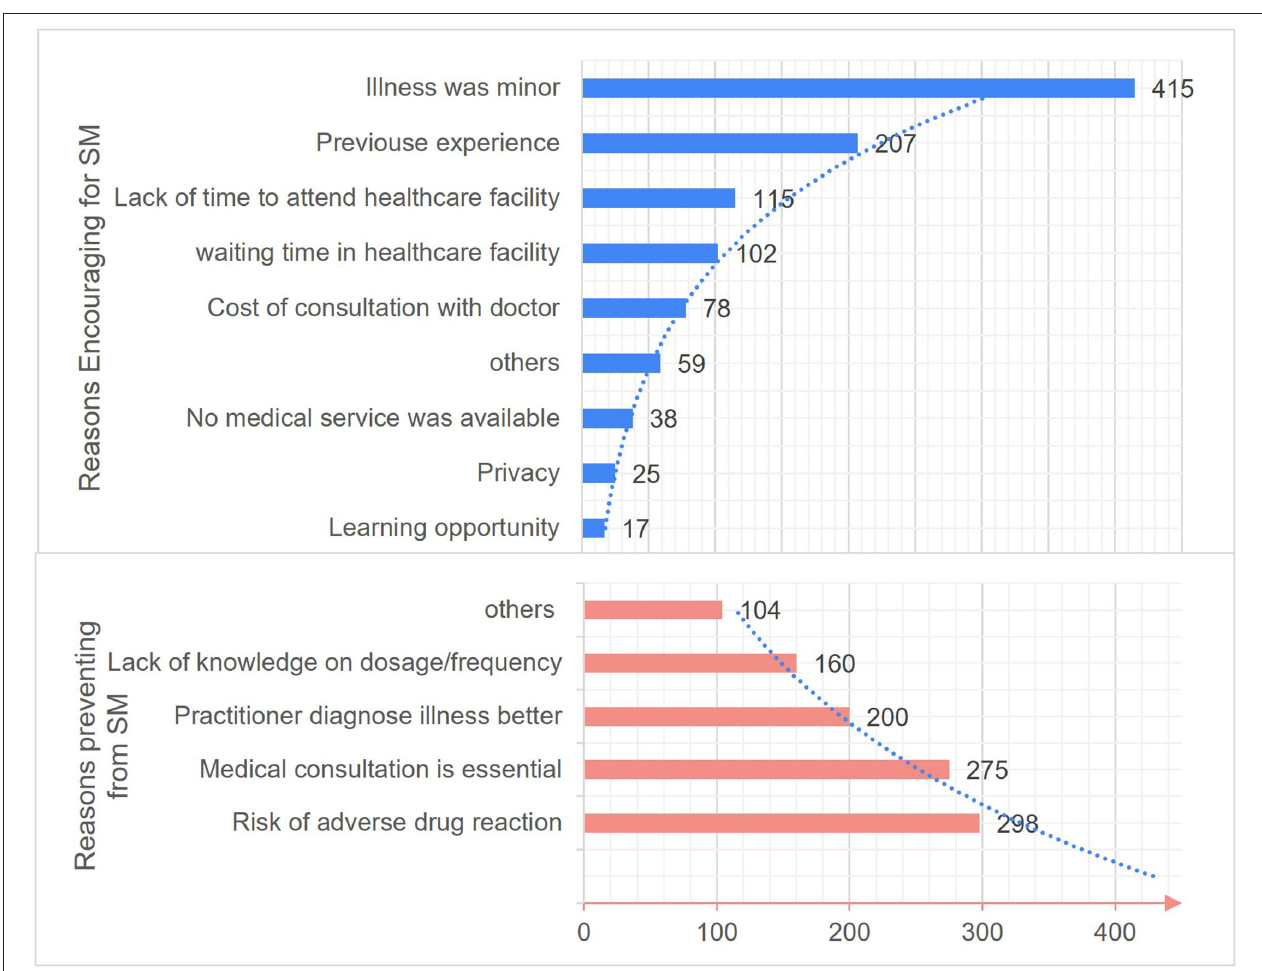
FIGURE 2 | Reasons impacting self-medication practice among Riyadh